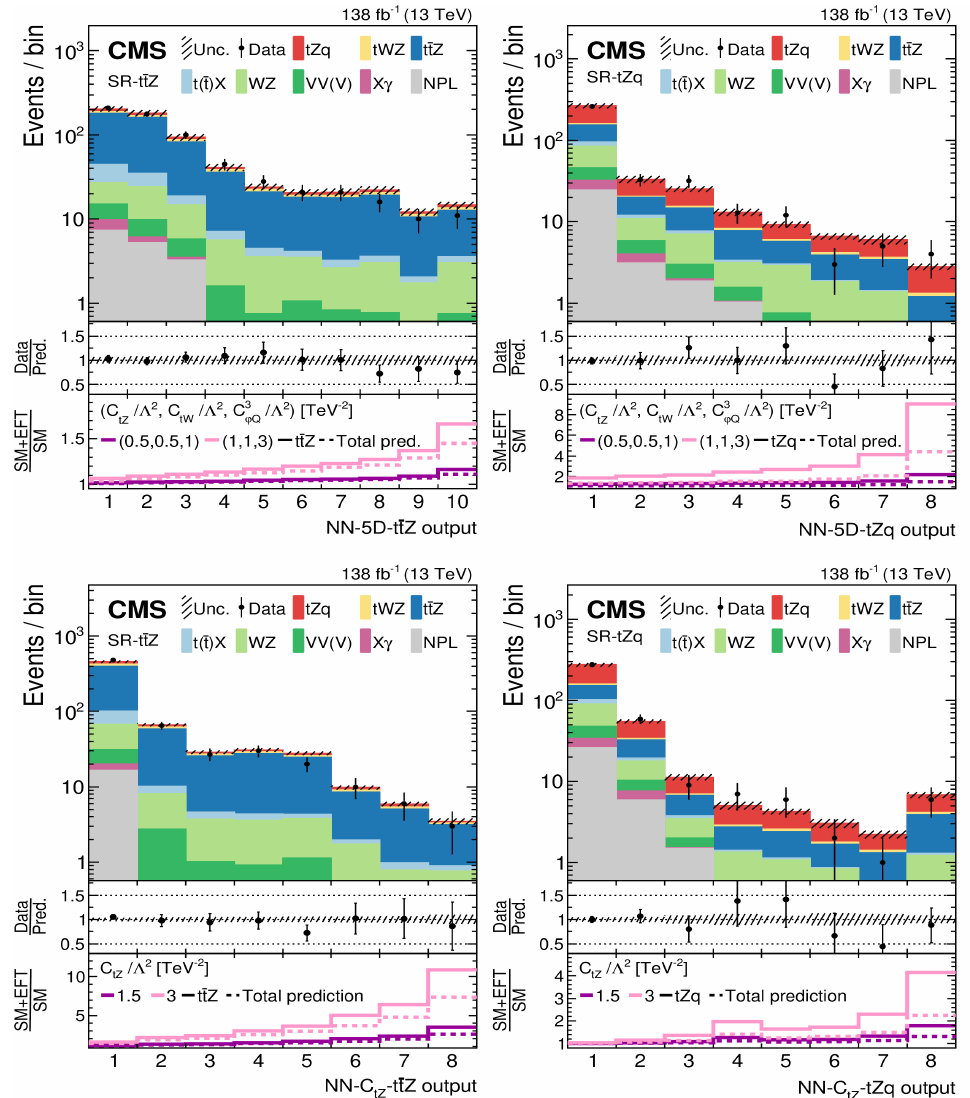
Figure 8. Post − fit distributions of the EFT neural networks in the t¯tZ and tZq signal regions from [22]. The top row shows the 5D discriminant while the bottom row shows the discriminant trained to target the effects of the c tZ operator. The middle ratio plot demonstrates the data/MC agreement, while the lower ratio demonstrates the increasing impact on the yields in each bin from larger WC